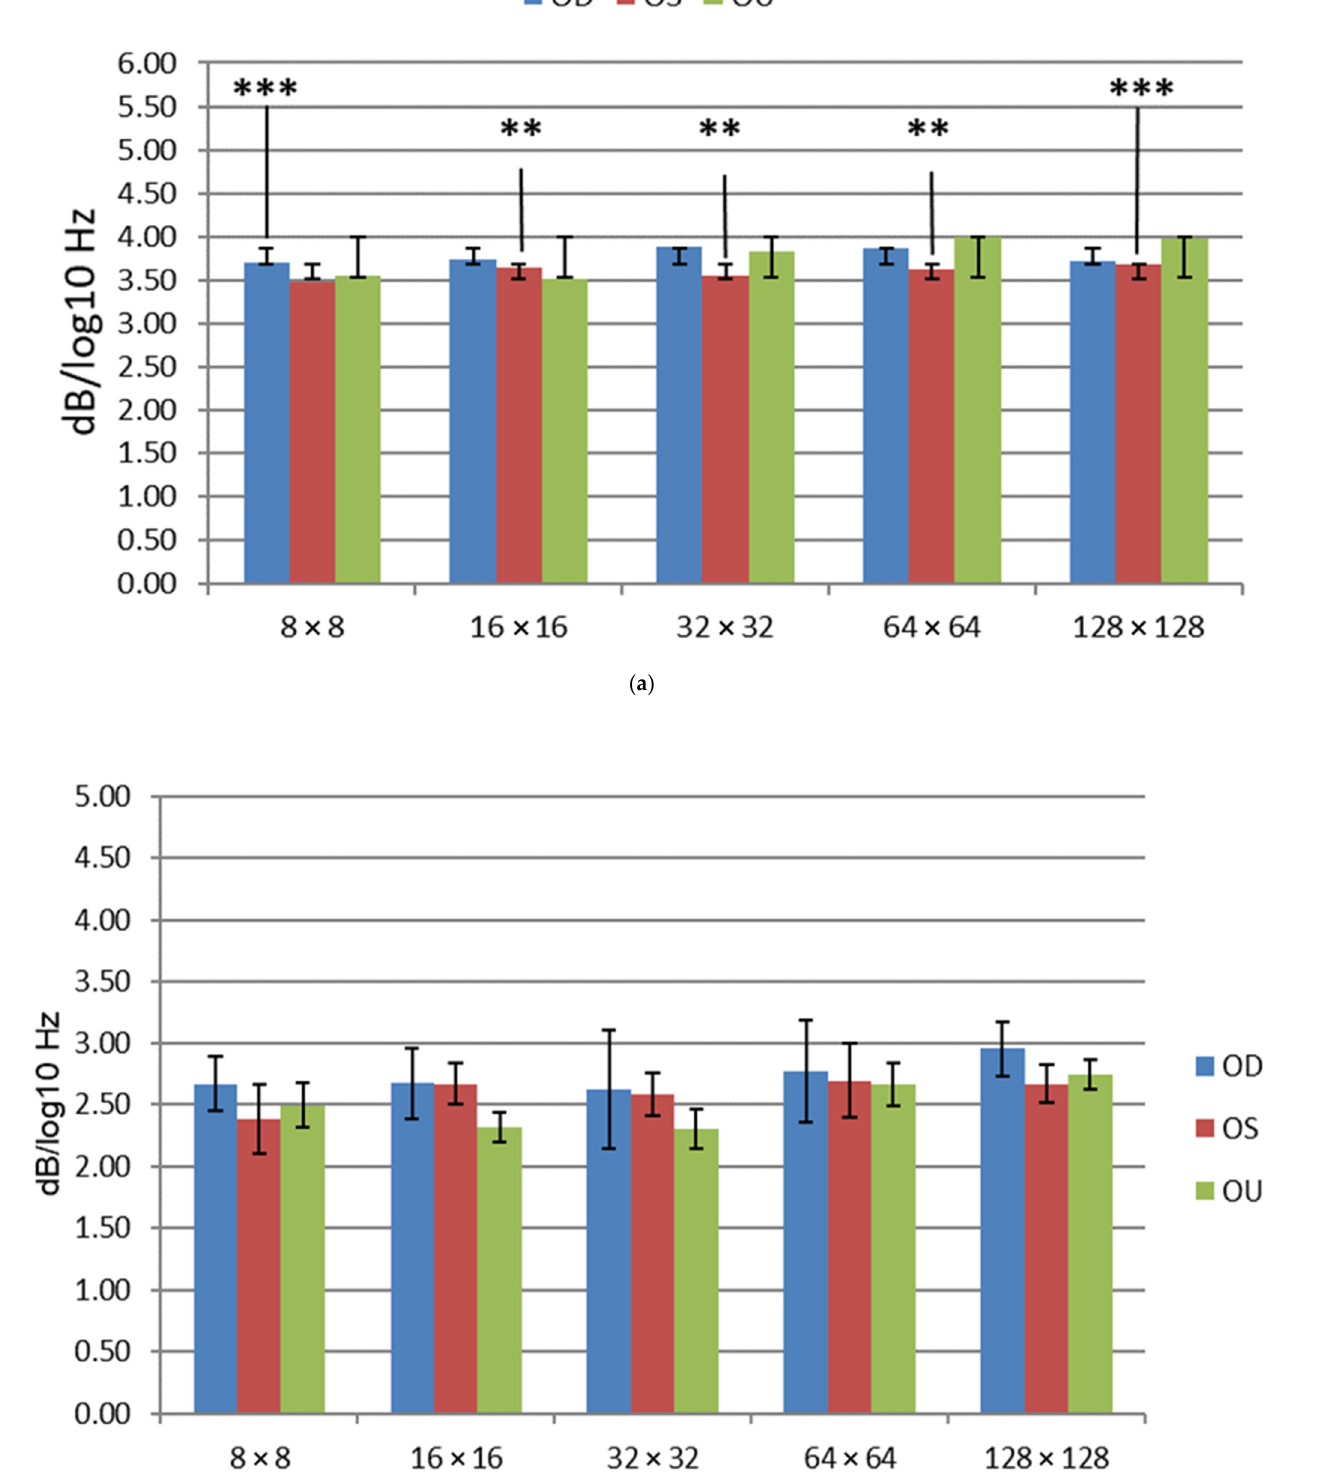
Table 5. PSD mean and standard error values, (a) TBI values, (b) and controls. mTBI